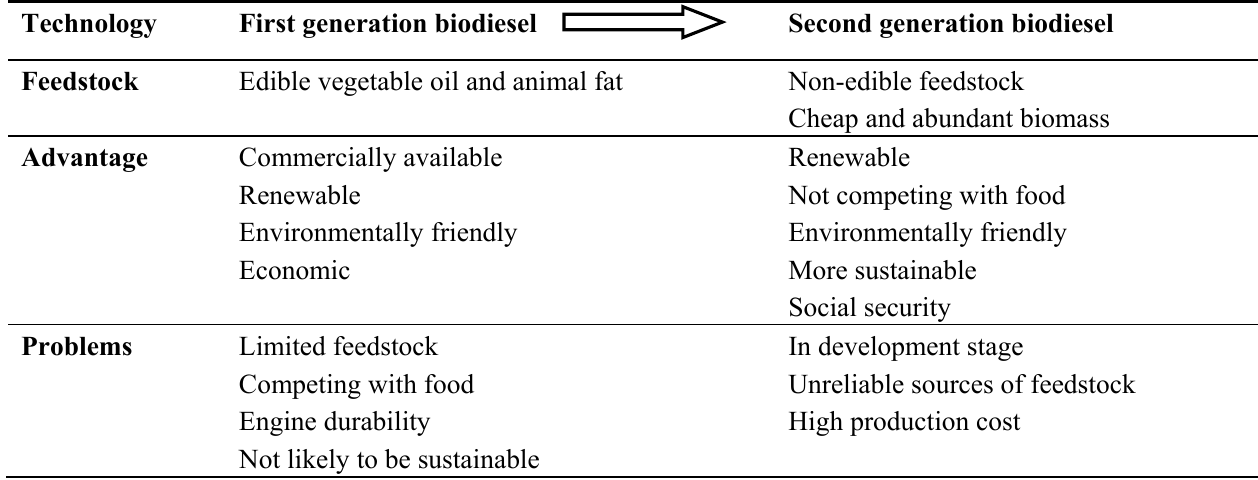
Table 1. Advances in biodiesel